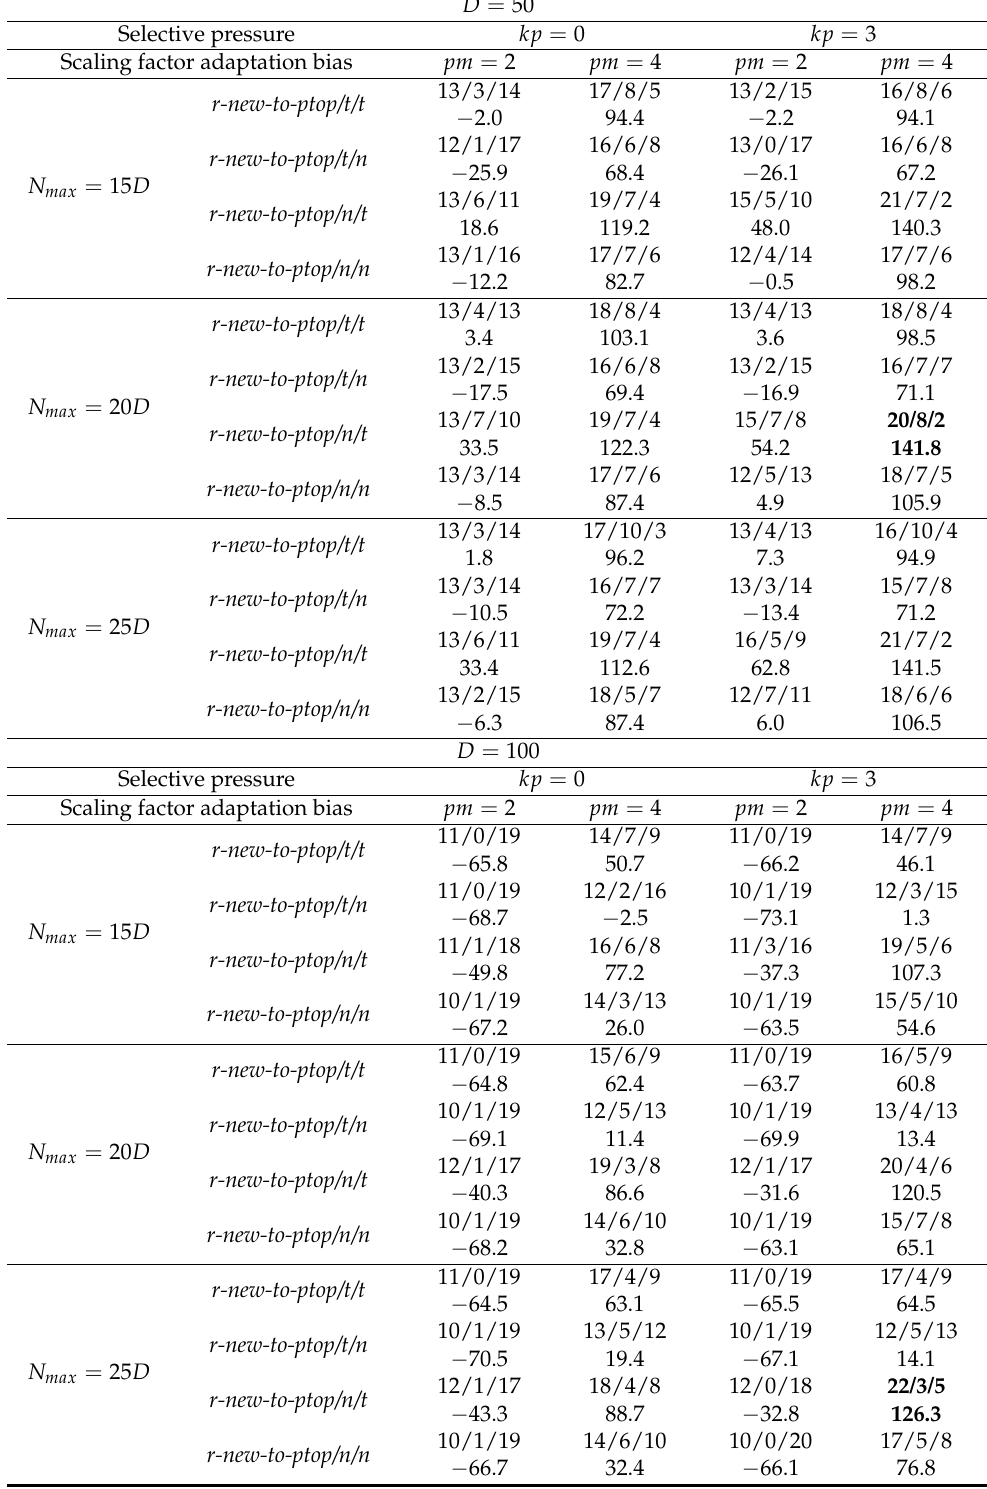
Table 3. L-NTADE vs. L-SHADE-RSP, CEC 2017, 50 D and 100 D , Mann–Whitney tests and total standard